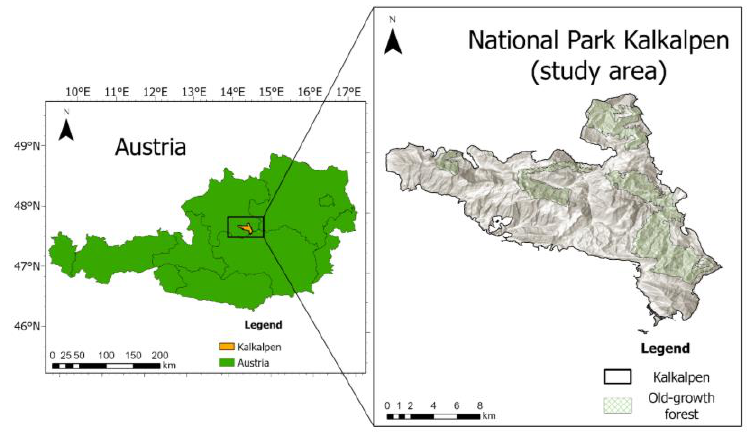
Figure 1. Study area, the National Park Kalkalpen in the state of Upper Austria,